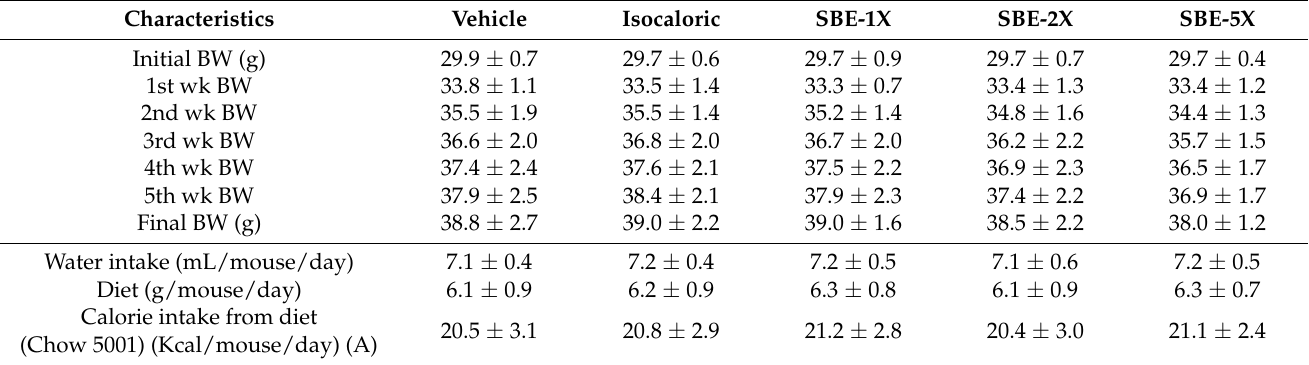
Figure 4. Effect of SBE supplementation on ( A ) liver, ( B ) kidney, ( C ) muscle, ( D ) heart, ( E ) lung, ( F ) adipocyte tissue, and ( G ) BAT tissue in mice. H&E stain, magnification: 200 × ; bar, 40 µ m; BAT magnification: 100 × ; bar, 80 µ m. Table 3. Effect of SBE supplementation on body weight, body composition, and water and diet